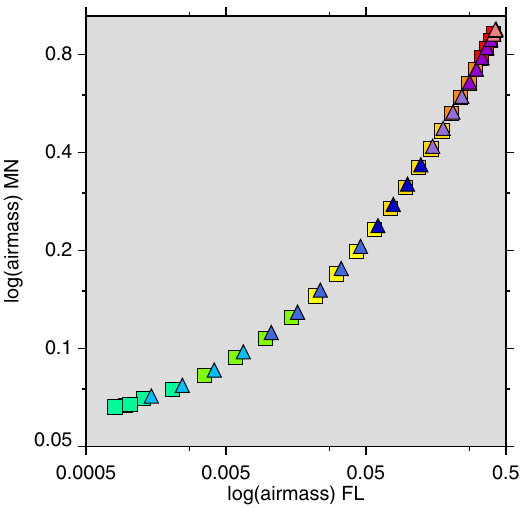
Figure 1. Weekly log(airmass) Rochester, Minnesota versus log(airmass) Miami, Florida (on log scale, thus double-log). Colors signify month. January–June, squares; July–December, triangles.